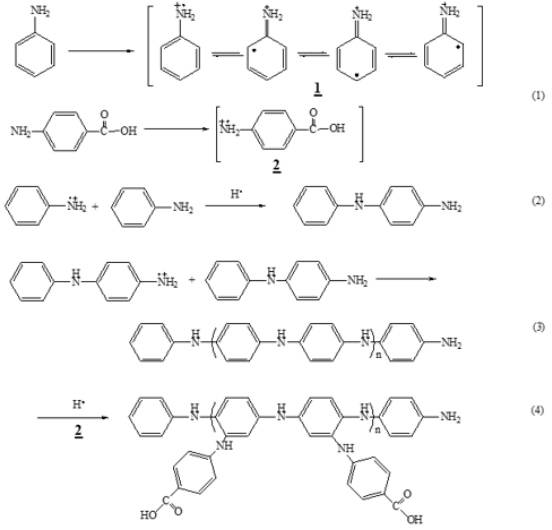
Figure 9. Possible polymerization mechanism of the funetional polyaniline during cold plasma process.